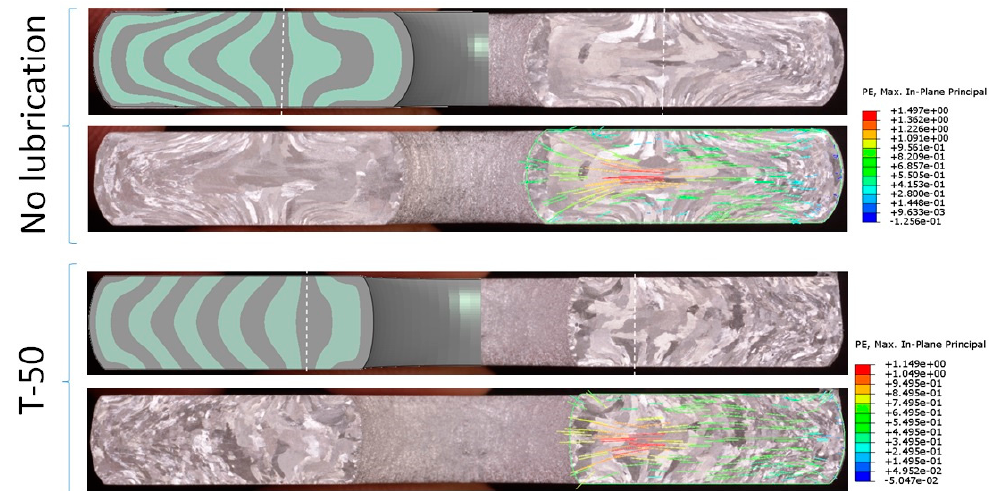
Figure 13. Comparison between predicted and experimental ring neutral radius and flow patterns for specimens R5 ( top ) and R13 ( bottom ), which represent the effect of lubrication at 450 °C , V = 350 mm/min.